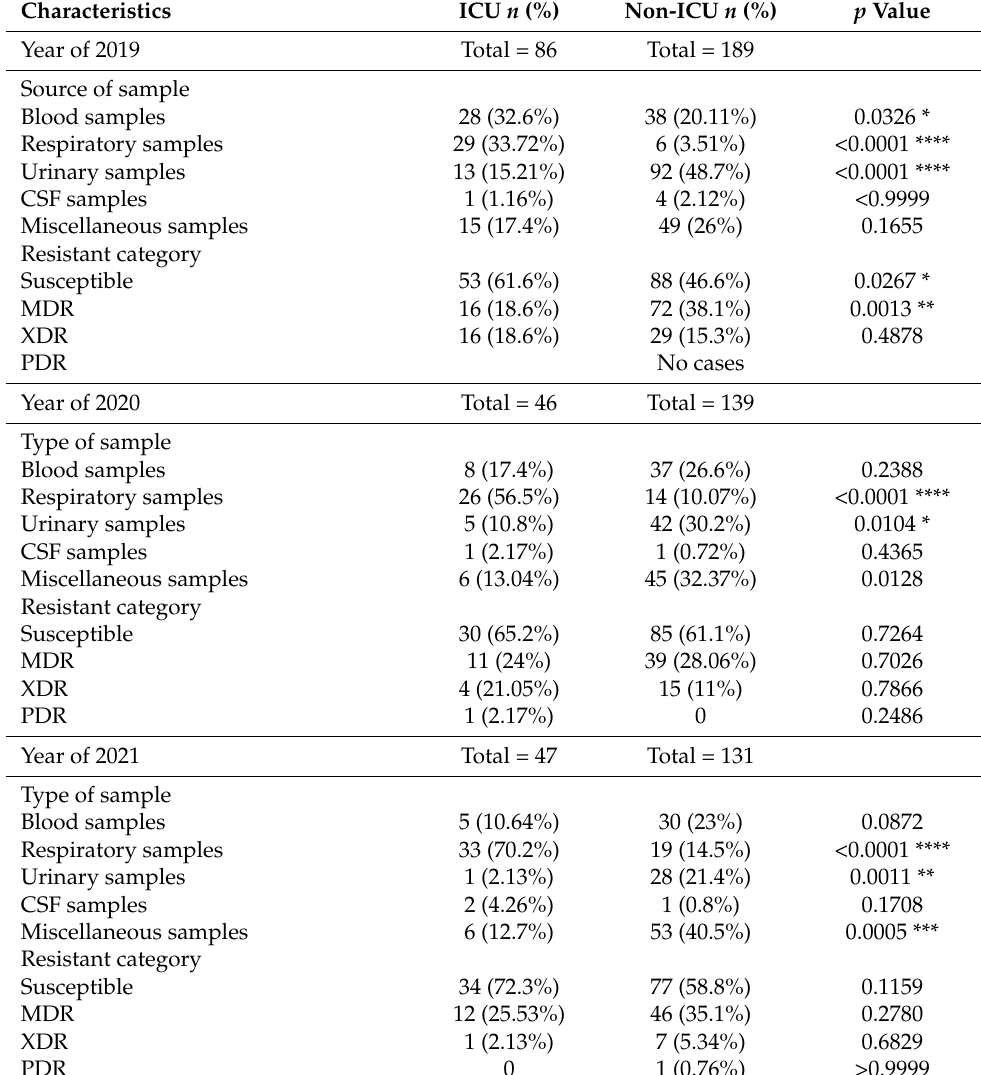
Table 3. Comparison among ICU and non-ICU patients over three years